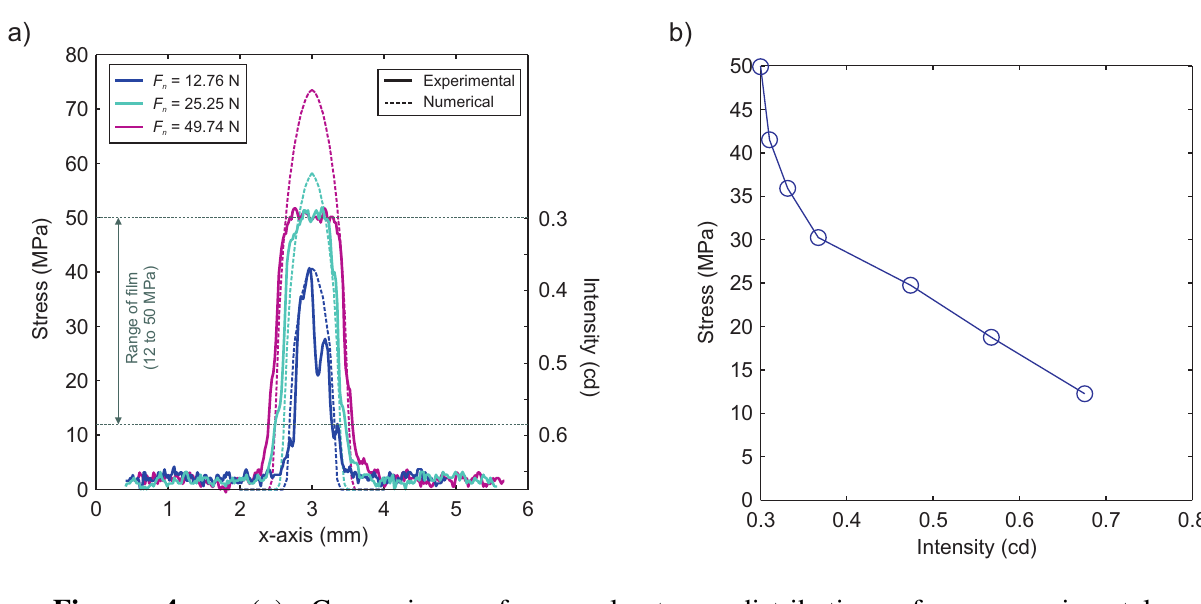
Figure 4. ( a ) Comparison of normal stress distributions from experimental pressure-sensitive film (solid lines) and the numerical model shown in Figure 3 (dashed lines) for various normal loads; ( b ) the relation between normal stress calculated numerically and the light intensity measured